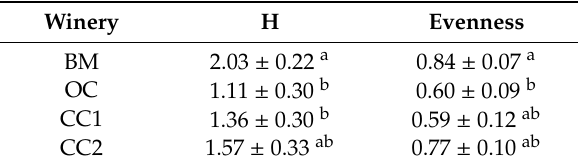
Table 3. Diversity indices calculated according to Shannon-Weaver [26] for the S. cerevisiae population obtained from the four wineries located in di ff erent winemaking areas (BM = Brunello di Montalcino DOGC, OD = Orcia DOC, and CC1 and CC2 = Chianti Classico DOCG). Values are expressed as means ± SEs; di ff erent superscript letters ( a and b ) within the same column indicate significant di ff erences (ANOVA, Tukey’s test at p < 0.05). Winery